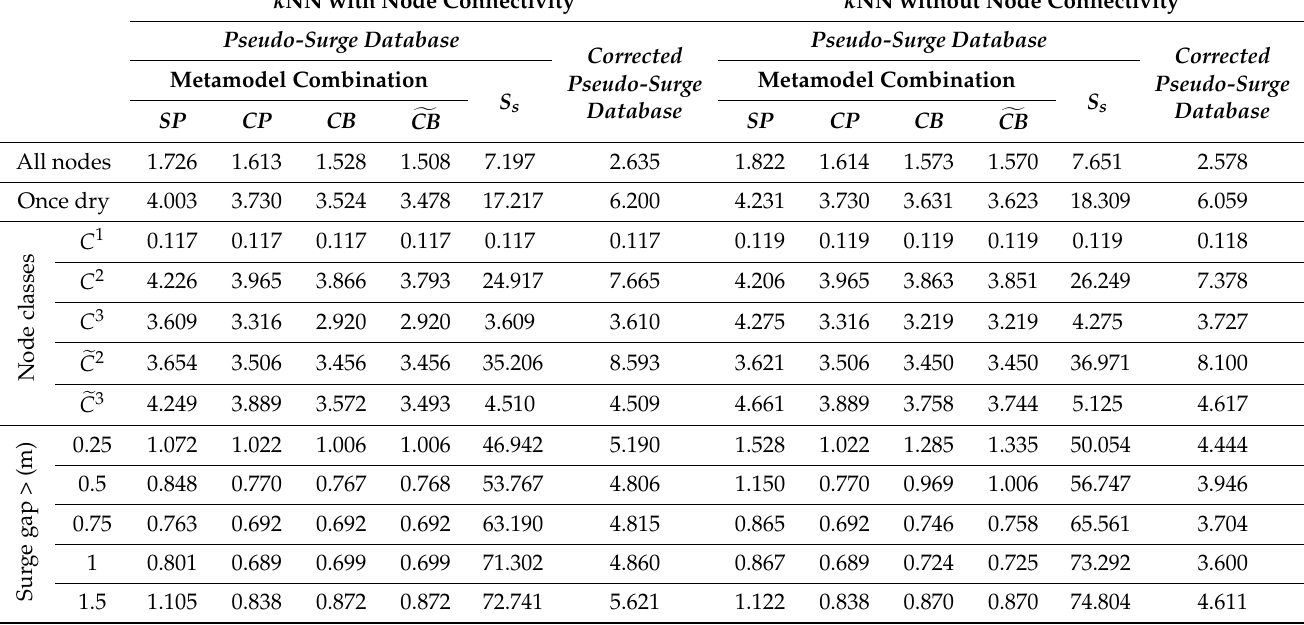
Table 8. Misclassification MC (%) averaged across different groups of nodes for different surrogate model variants for the implementation that considers different surge metamodels for different classes of